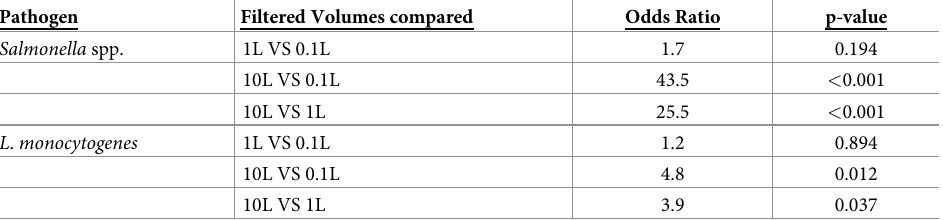
Table 4. Odds ratios of recovery of Salmonella and L . monocytogenes by comparison of different filtration volume. P-values less than 0.05 are significant. Pathogen Filtered Volumes compared Odds